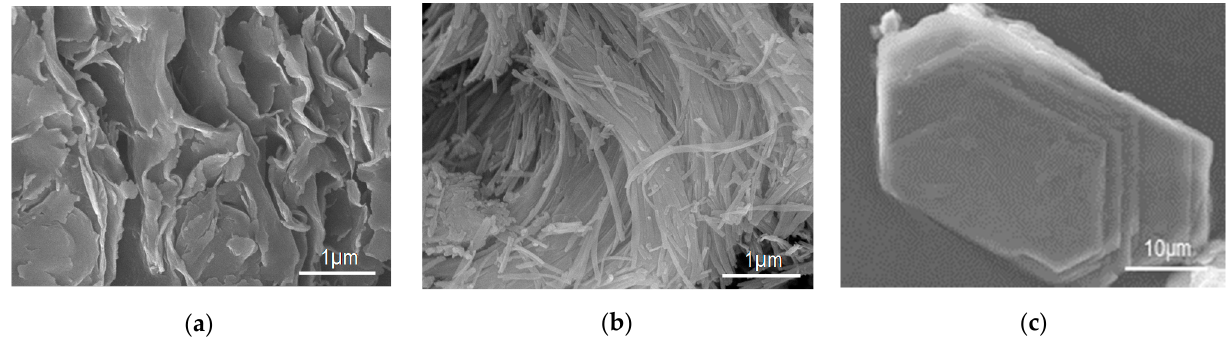
Figure 2. SEM images of: ( a ) montmorillonite; ( b ) sepiolite; ( c )